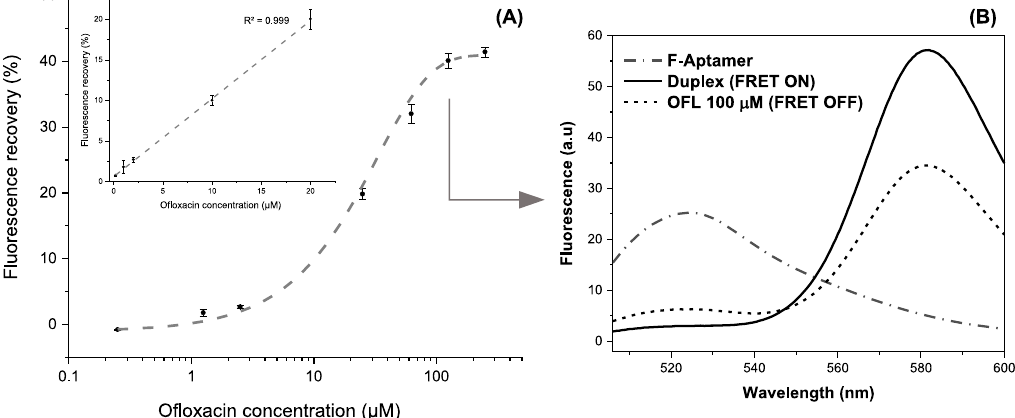
Figure 9. ( A ) Calibration curve in the range of 0.2–200 μ M of OFL in the logarithmic scale (inset: Linear Linear working range between 0.2 and 20 µ M) (error bars are obtained with n = 3) ( B ) Fluorescence working range between 0.2 and 20 μ M) (error bars are obtained with n = 3) ( B ) Fluorescence spectra spectra snapshotting the di ff erent apta-assay steps for a fixed target snapshotting the different apta-assay steps for a fixed target concentration.